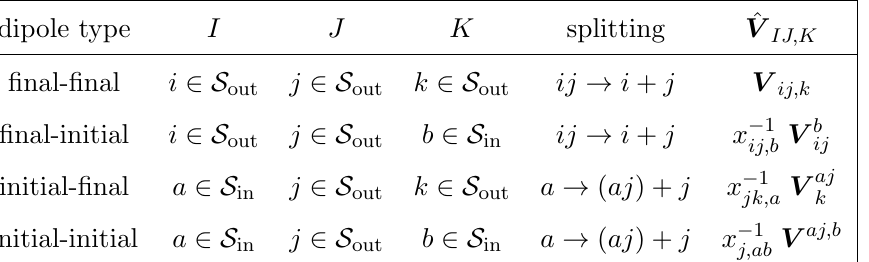
Table 3 . Correspondence between the generic splitting kernels ^ V of [35]. For initial-state and (cid:12)nal-state partons we use speci(cid:12)c indices a; b Moreover, since the emittee J we identify J = j . The terms with initial-state emitters, 2 S out I = a , describe splittings a ( aj ) + j , while (cid:12)nal-state emitters, I = i 2 S in ! to splittings ( ij ) i + j . The spectators K can be either initial-state ( K = b ) or (cid:12)nal-state ! ( K = k )